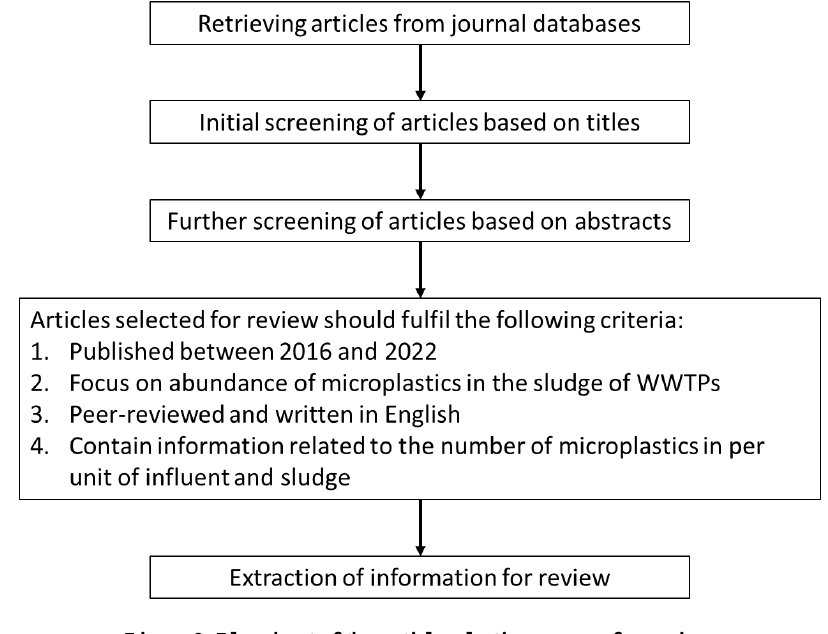
Figure 2. Flowchart of the article selection process for